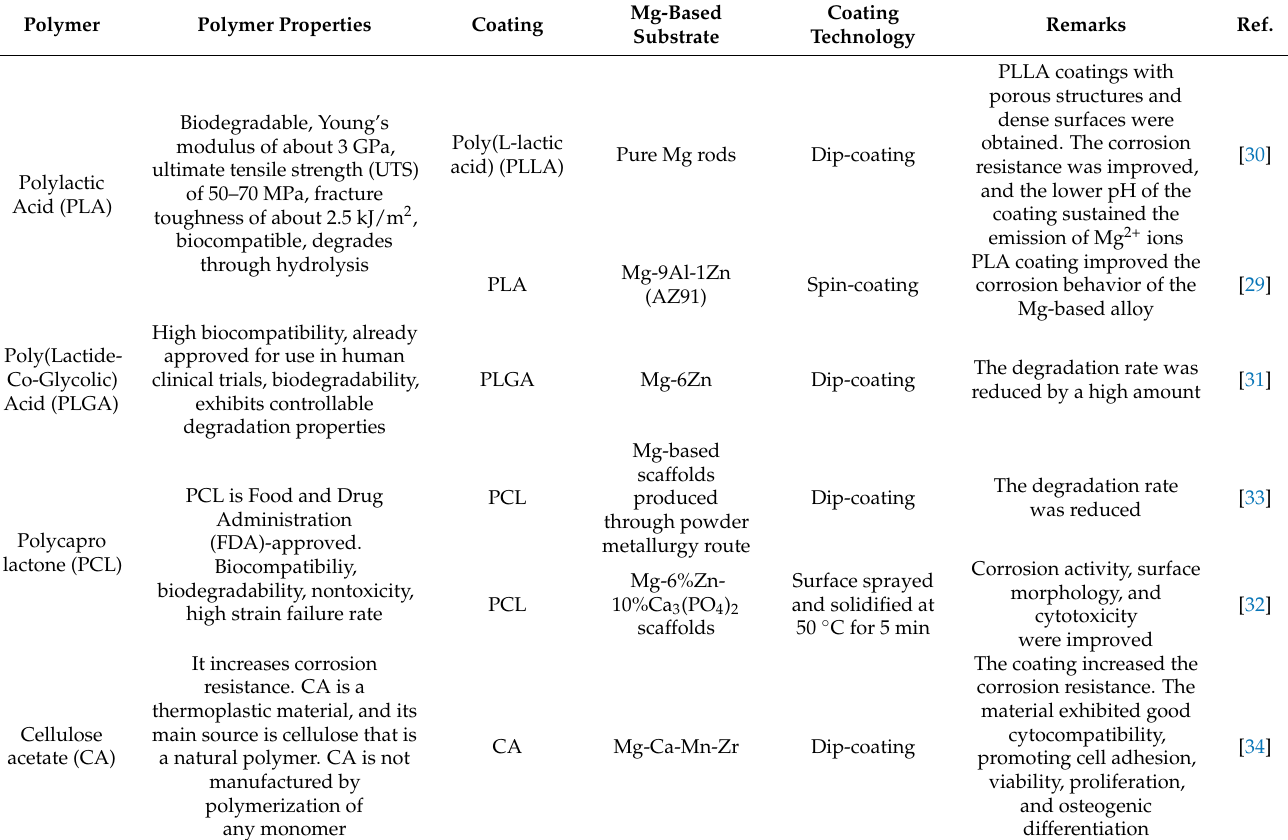
Table 1. Characteristics and effects of synthetic polymer coatings on Mg-based